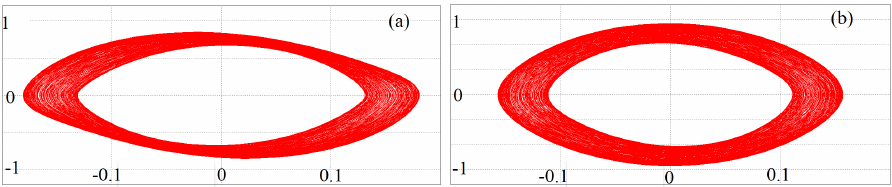
Figure 20. Phase-space diagrams of the circuit when f = 12.892 kHz. The corresponding ω nd = 4.05. ( a ) x -axis is the voltage of y 1 in V and y -axis is the voltage of z 1 , ( b ) x -axis is the voltage of y 2 in V and y -axis is the voltage of z 2 in V. The initial condition has been chosen at (0.333,0,0,0) to obtain the phase portraits. (Color